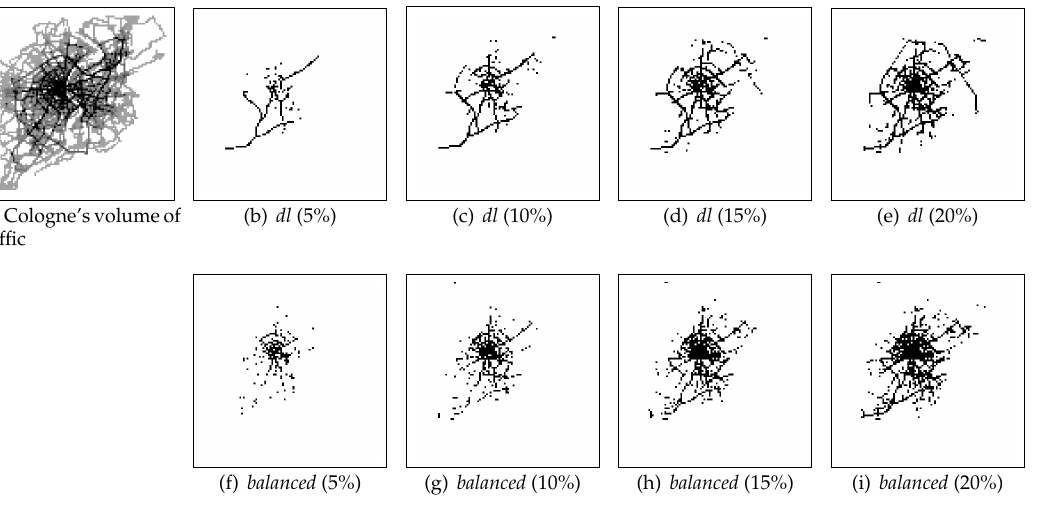
Figure 7. Layout of roadside units deployed by dl and balanced . ( a ) Shows the Cologne traffic. The darker the area, the more intense is the flow. ( b – e ) Show the layout of roadside units deployed by dl for covering 5%, 10%, 15%, and 20% (respectively) of the road network. Similarly, ( f – i ) present the layout of roadside units deployed by balanced for covering the same